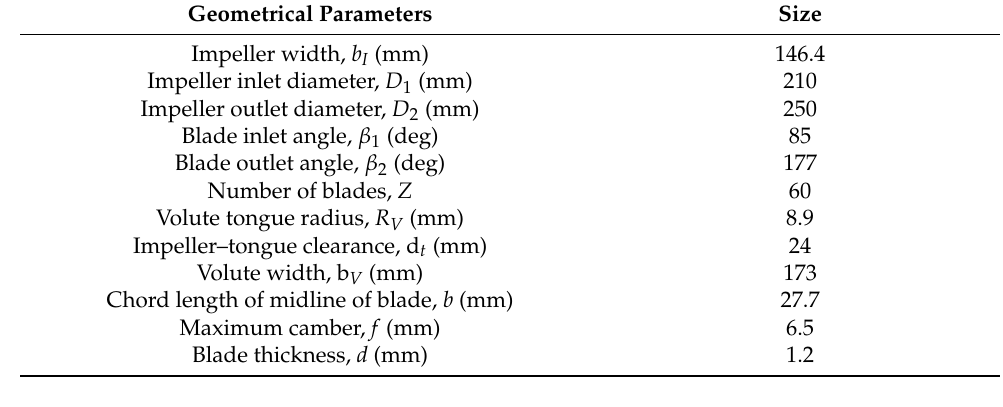
Figure 2. Structure diagram of a range hood. Figure 3. Geometric parameters of squirrel-cage fan. Table 1. Geometrical parameters of the squirrel-cage fan.